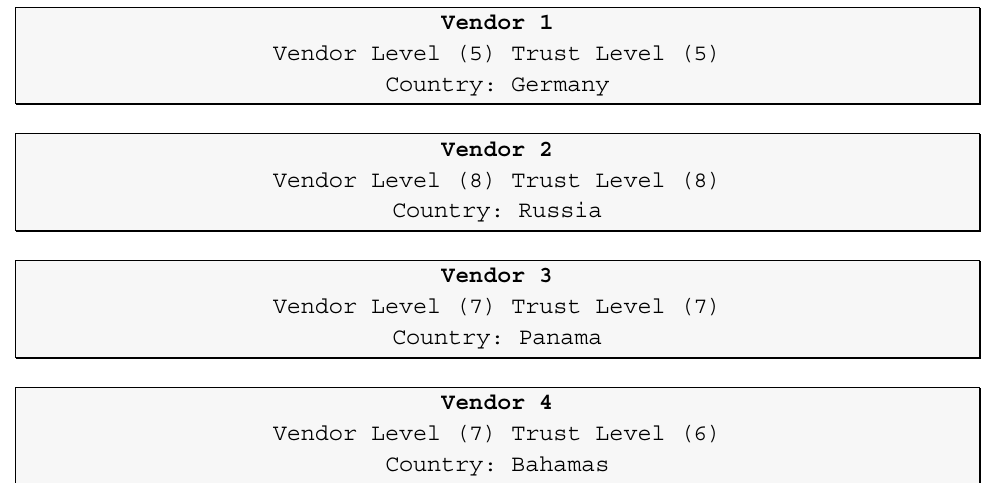
Figure 8. Marketplace Vendors Positively Identified (Names Redacted).